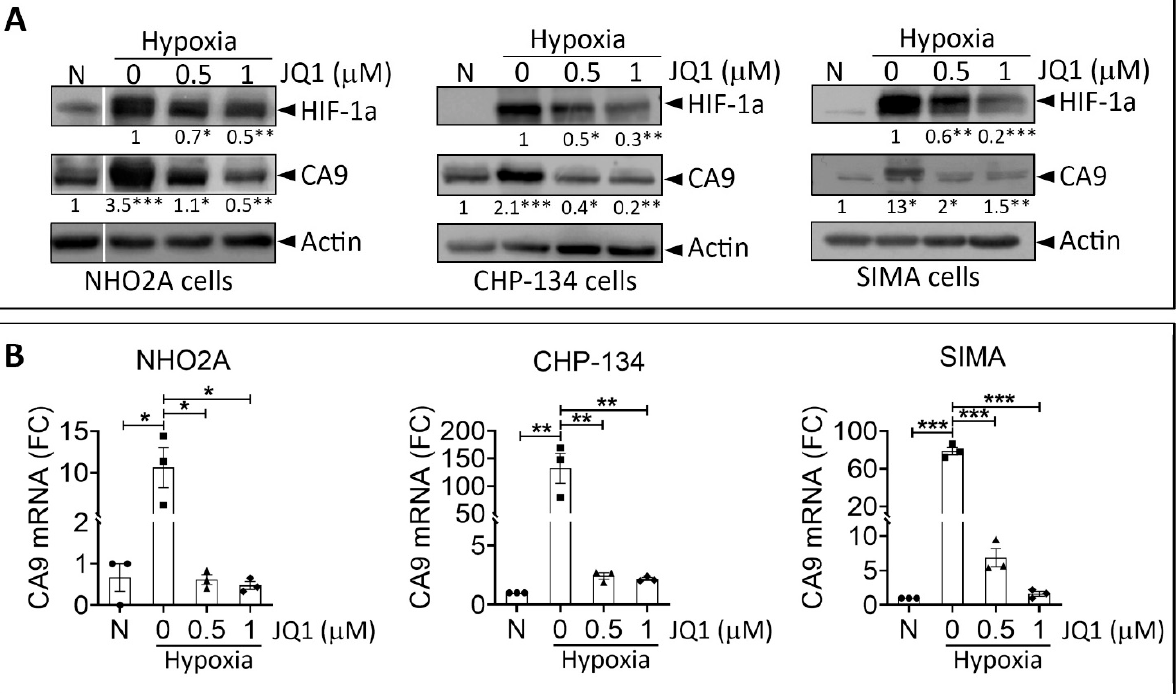
Figure 1. Effect of JQ1 on the hypoxia status of NB cells in vitro. ( A ) Western blot test showing the protein expression of HIF-1 α and CA9 in NHO2A, CHP-134, and SIMA cells cultured under normoxia (N) or hypoxia and treated with JQ1 at the indicated concentration. Actin was used as a loading control. The quantification of band intensity corresponding to HIF-1 α and CA9 in treated hypoxic cells is reported compared to untreated hypoxic cells and normoxic cells, respectively. ( B ) RT-qPCR measurement of CA9 mRNA in cells described in ( A ). Bars represent means from three independent experiments ± SEM. Statistically significant difference was calculated by unpaired two-tailed Student’s t -test (* p < 0.05, ** p <0.01; and *** p <